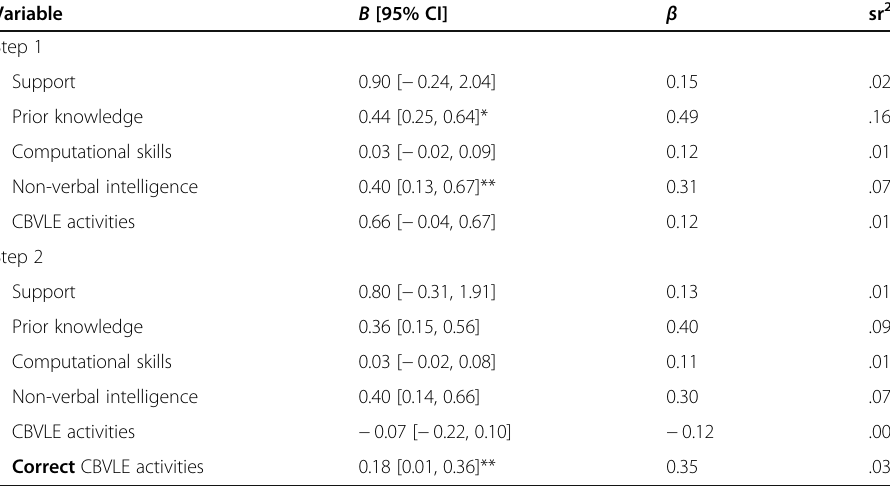
Table 4 Regression coefficients and semi-partial correlations (sr 2 ) for each predictor variable Variable B [95% CI] sr